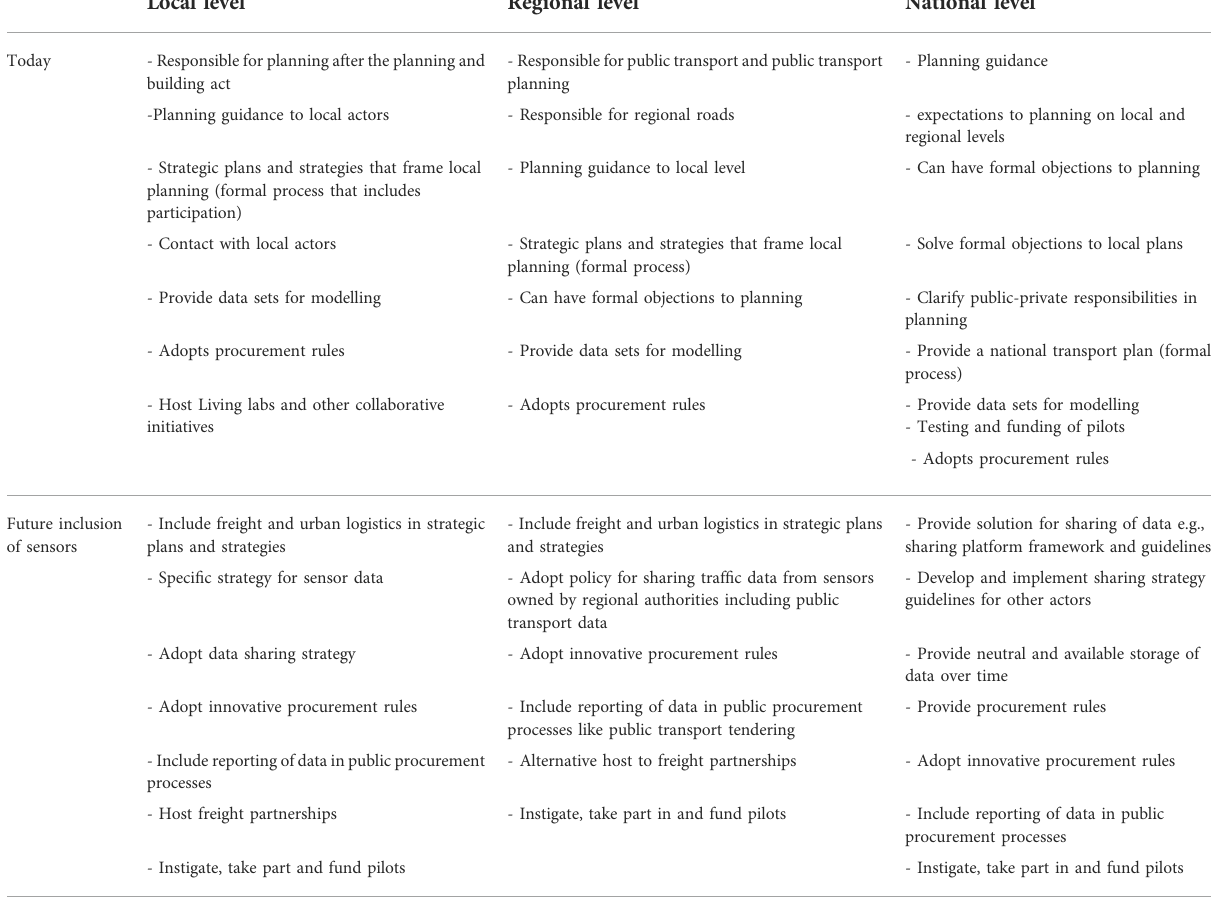
TABLE 2 How to include sensor data into planning practice across government